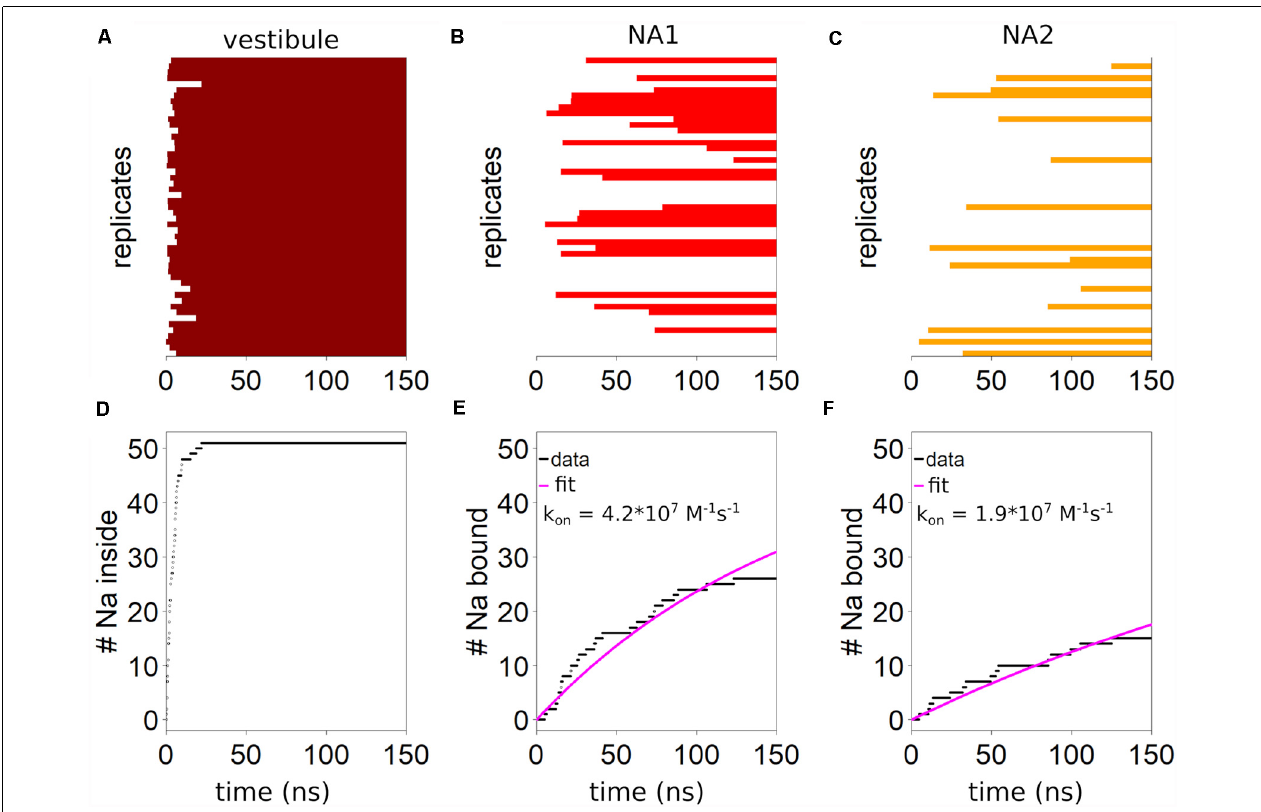
FIGURE 2 | Kinetics of sodium binding. The presence of at least one sodium ion (A) in the vestibule is indicated by a horizontal dark red bar for the 51 simulations or replicates. The outer salt bridge between R104 and E493 is defined as the boundary for being within the outer vestibule. (B) Binding of sodium to NA1 is indicated by red horizontal bars. (C) The presence of sodium in NA2 is symbolized by orange bars. Cumulative number of trajectories (replicates) showing (D) sodium ions entering the vestibule, (E) bind to NA1 or (F) to NA2. Estimation of the first order rate constant of sodium binding by fitting an exponential equation of the form: y = A · (51-e -bt ), with the pre-factor constrained to 51 assuming all conformations are capable of